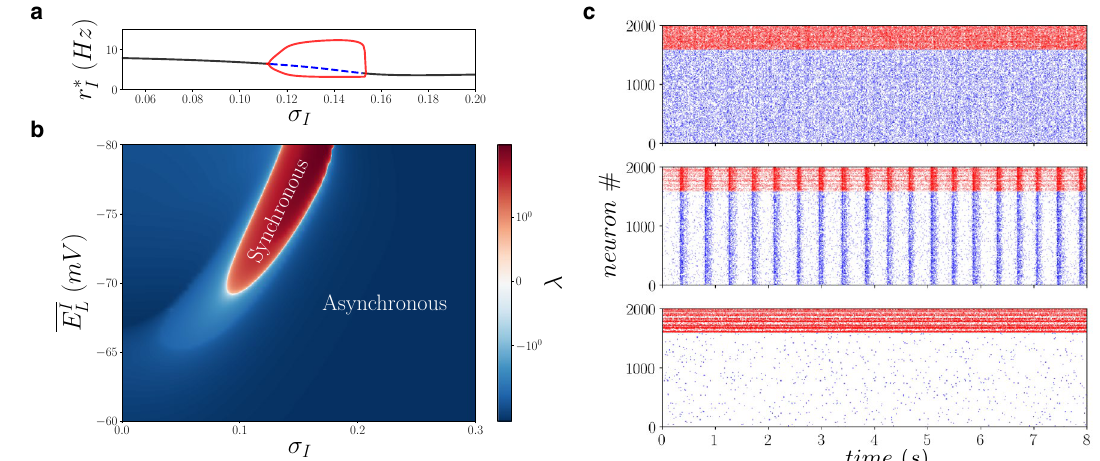
Figure 4. Heterogeneous networks admit more dynamical regimes compared to homogeneous networks. ( a ) Inhibitory neurons population stationary firing rate r ∗ I in function of σ I for E I L = − 70 mV. Black line indicates stable ( (cid:31) < 0 ) asynchronous state, dashed blue line indicates unstable ( (cid:31) > 0 ) asynchronous state where a limit cycle appears (red lines indicates maximum and minimum value of r I in time). ( b ) The largest stability Lyapunov exponent (cid:31) (real part) of the asynchronous state as a function of the average resting potential of inhibitory neurons E I L and their standard deviation σ I . Whenever (cid:31) > 0 the asynchronous state is unstable and a stable limit cycle appears. In direct network simulations we observe sparsely synchronous oscillations (see raster plots in panel ( c ) where we use E I L = − 70 mV and σ I = 0, 0.12, 0.2 from top to bottom). In these simulations Q EE = 1.53